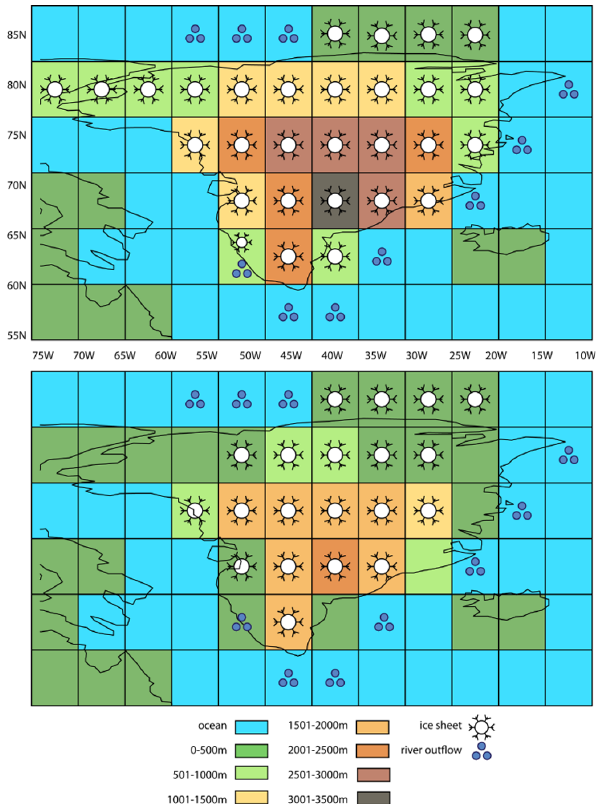
Fig. 1. Configuration of the GIS as used in the simulations. Depicted are the reference PI state (top panel) and the state with decreased elevation and extent of the GIS (lower panel). The latter state is obtained by decreasing the total ice volume of the GIS by 30%. The elevation of the different grid cells is given in green and brownish colours, the ocean grid cells are blue, and different symbols indicate the river outflow points and the grid cells covered by ice. Many grid cells partially represent ocean and partially land. For this figure, a cell is depicted as ocean if at least 90% of the cell consists of ocean. As a result, the most easterly outflow point appears to be detached from the mainland; there is however both land and ocean in the adjacent grid cell. The outlines of the continents are for reference